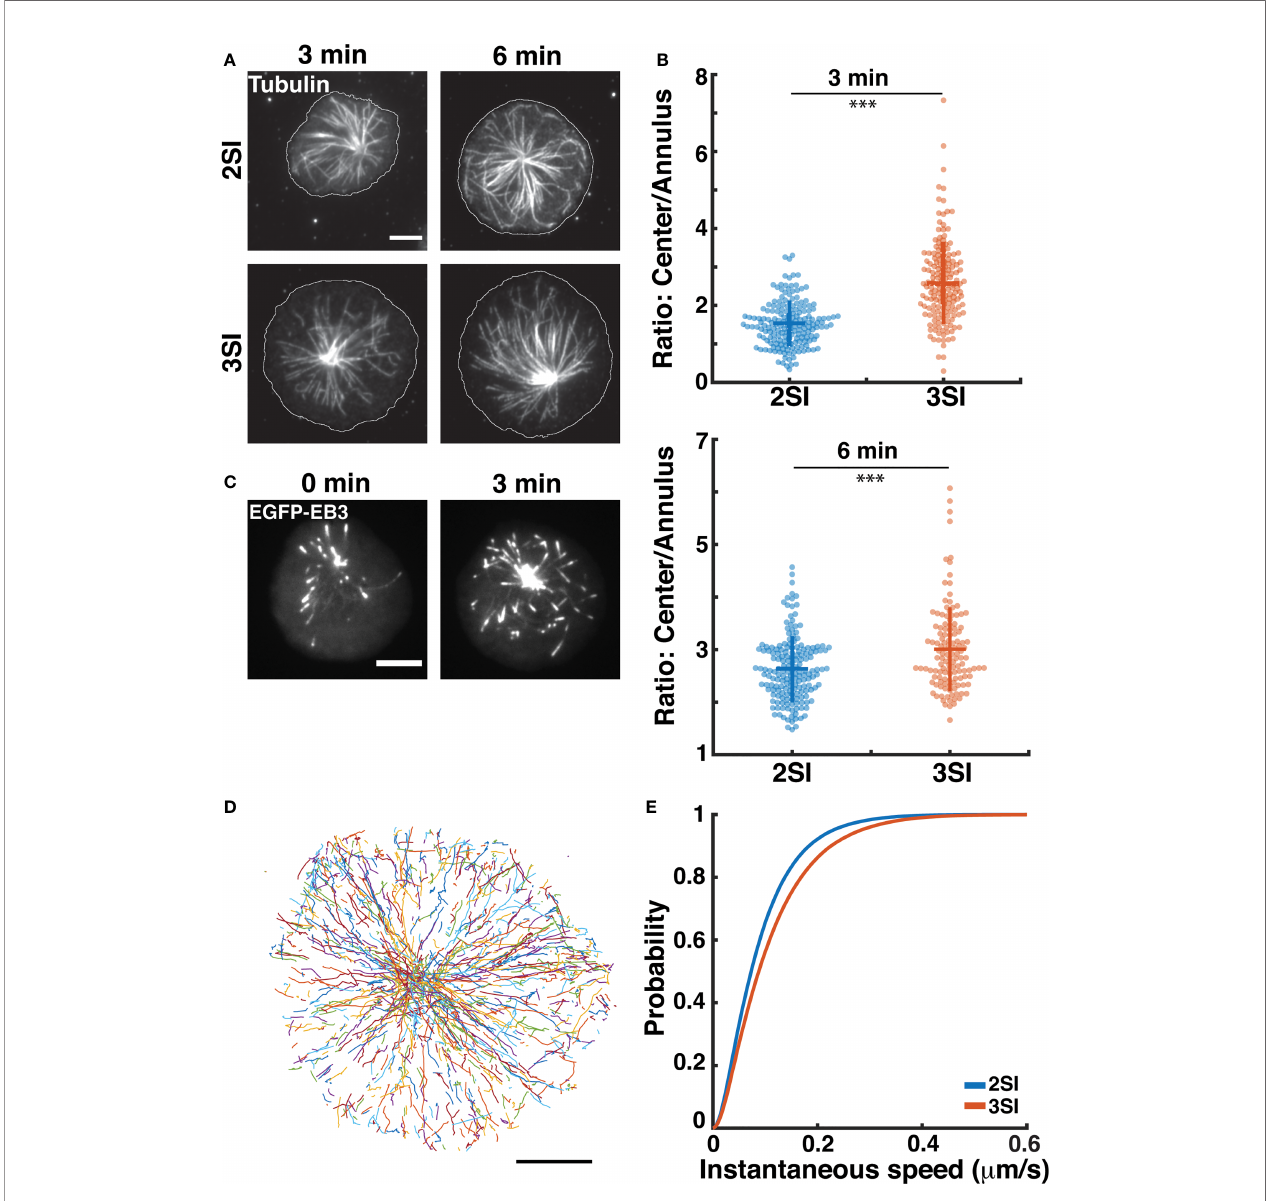
FIGURE 4 | 3SI CTLs display altered microtubule growth rates: (A) Representative TIRF images of 2SI and 3SI CTLs fi xed at 3 and 6 min and stained with anti- b - tubulin to visualize microtubules. Cell outline is shown in white. (B) Ratio of tubulin fl uorescence intensity at the center to the annulus at 3 and 6 min. Data taken from at least 130 cells from 3 independent experiments. Wilcoxon rank-sum test performed to calculate p-values. ***p<0.001. (C) Representative time-lapse images of a 3SI CTL expressing EGFP-EB3 spreading on an anti-CD3-coated coverslip and imaged using TIRF microscopy. (D) All EB3 tracks for a representative 3SI cell. (E) Cumulative distribution function of instantaneous microtubule tip. n=12 cells for 2SI, 16 cells for 3SI from 4 independent experiments. For EB3 speeds, p=0.009 (two sample Kolmogorov-Smirnov test). All scale bars represent 5